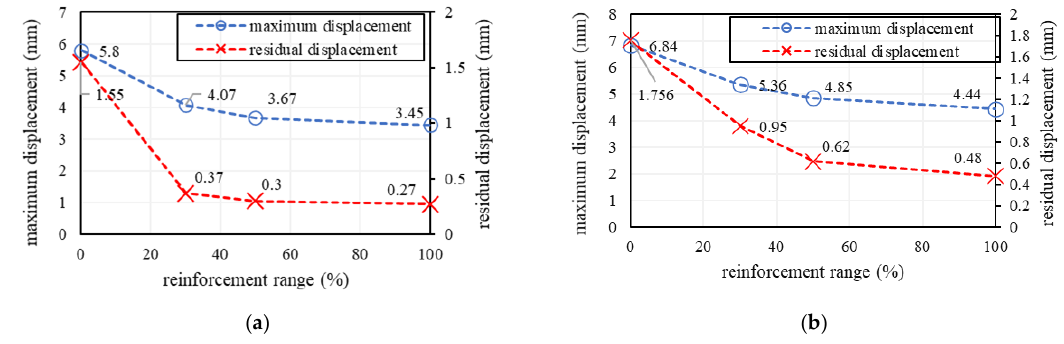
Figure 32. Comparison of maximum displacement and residual displacement of TYPE-D: ( a ) wave A; ( b ) wave